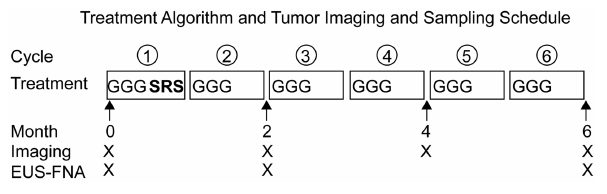
FIGURE 1 |Treatment algorithm and tumor imaging and sampling schedule . Patients with locally advanced, unresectable pancreatic adenocarcinoma received full-dose gemcitabine (G) plus concurrent hypo-fractionated stereotactic radiosurgery (SRS). Stereotactic radiosurgery was administered on the off week of the first cycle of gemcitabine. Restaging imaging was performed every 2months. Endoscopic ultrasound with fine needle aspiration (EUS-FNA) with fiducial placement was performed prior to therapy and serial EUS-FNAs were performed after 2 and 6months of